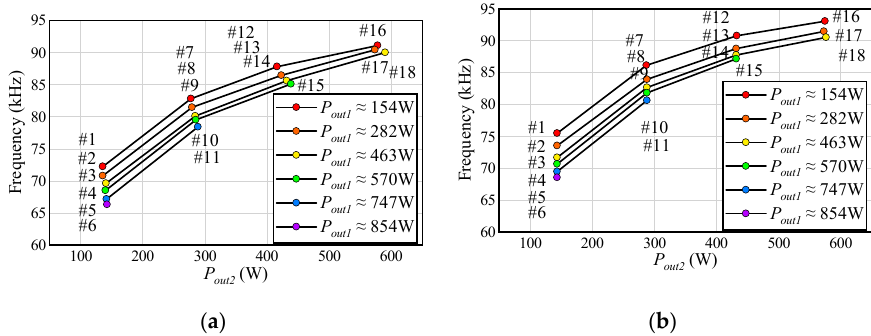
Figure 15. Results of f tx for each measurement point: ( a ) Experimental results; ( b ) Simulation results.